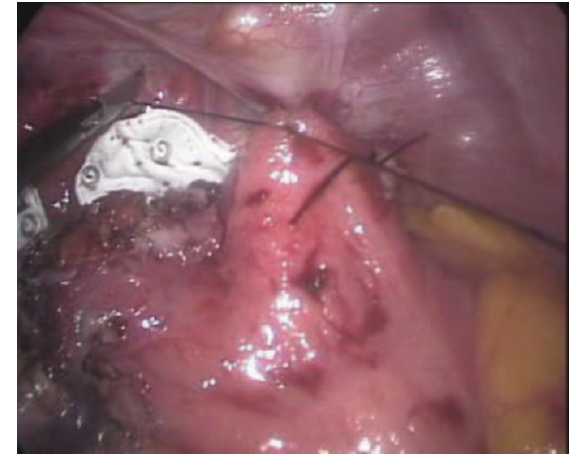
Figure 7. Gastropexy to triangular ligament of